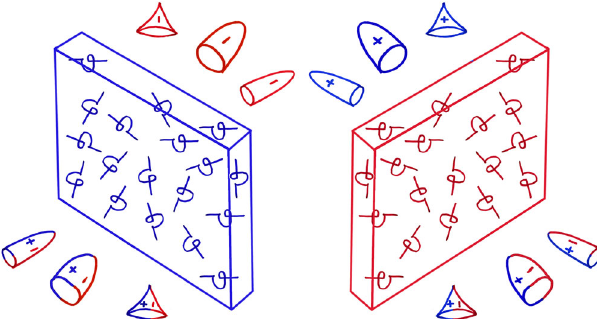
m.FIG. 4. Two slabs containing lossy maximally electromagneti- cally chiral and reciprocal objects of opposite handedness. For large enough slab thickness, particle density, or losses, each slab filters out one of the helicities by absorption. The other one passes right through. This behavior is independent of the angle of incidence. The slabs can be used to design glasses for viewing 3D projections where the images destined for each eye are encoded in the two circular polarizations. The glasses would allow us to see the 3D effect even at large angles from the perpendicular of the